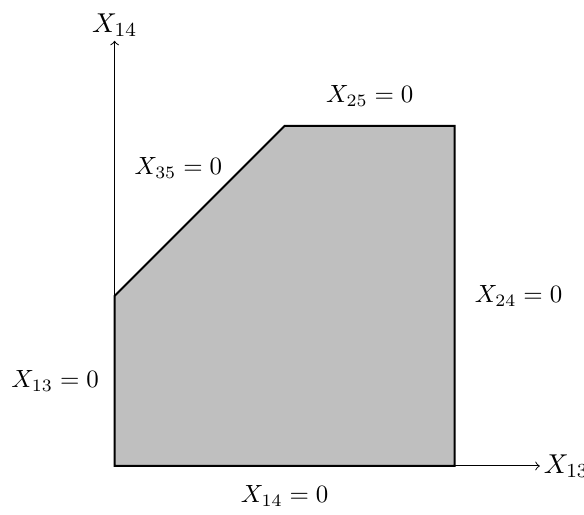
Figure 1 . The shaded area is the kinematic associahedron for n =